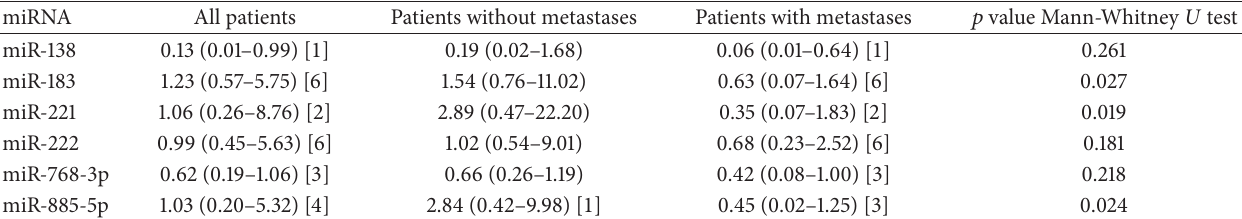
Table 5: Comparison of relative expressions of miRNA between patients without metastases and patients with metastases. miRNA